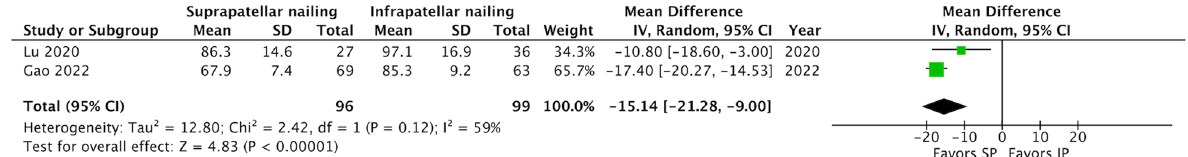
Fig. 8 Forest plot of the surgical time. The SP group had a shorter surgical time than the IP group (MD: P < 0.001; I 2 59%). CI confidence interval; MD mean =